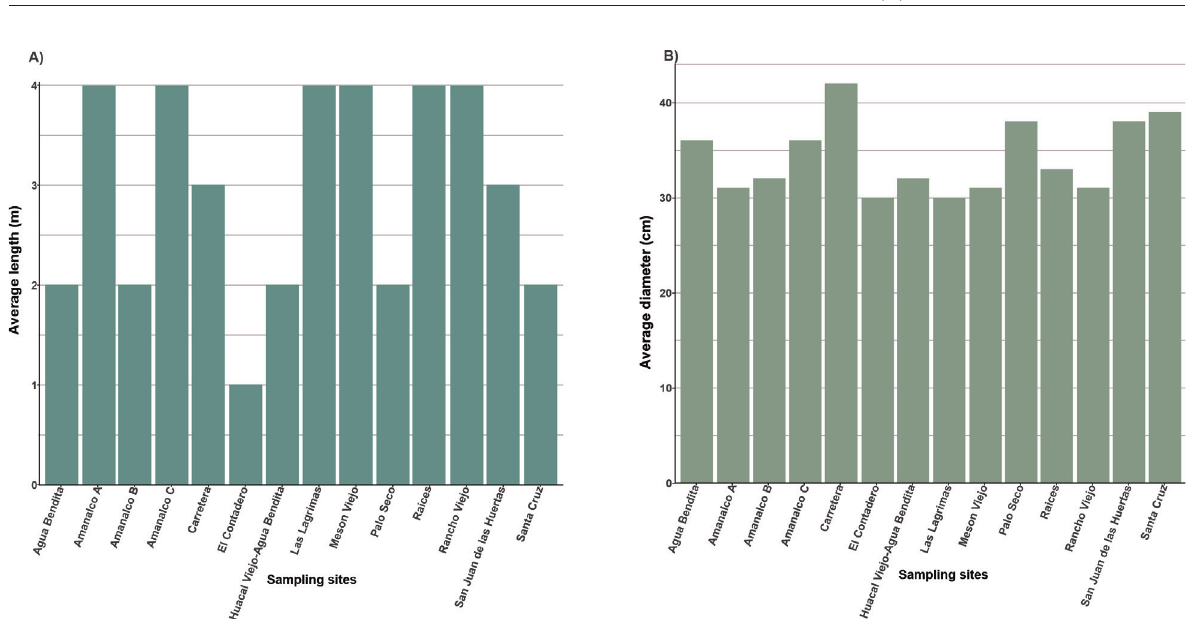
Figure 8. Average length ( A ) and average diameter ( B ) of logs per site.